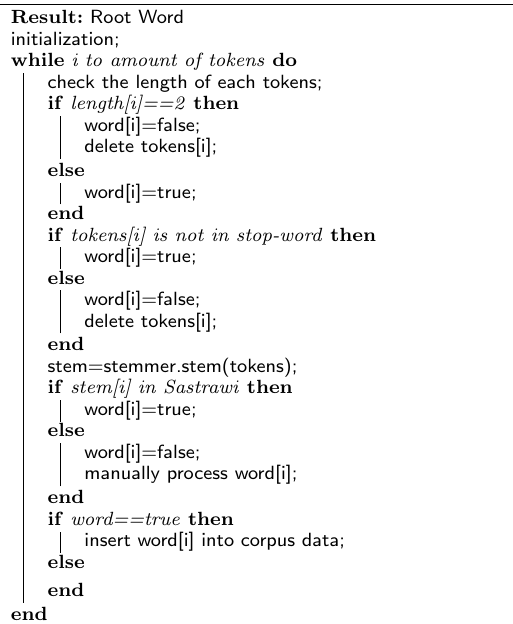
Algorithm 1: The algorithms of data